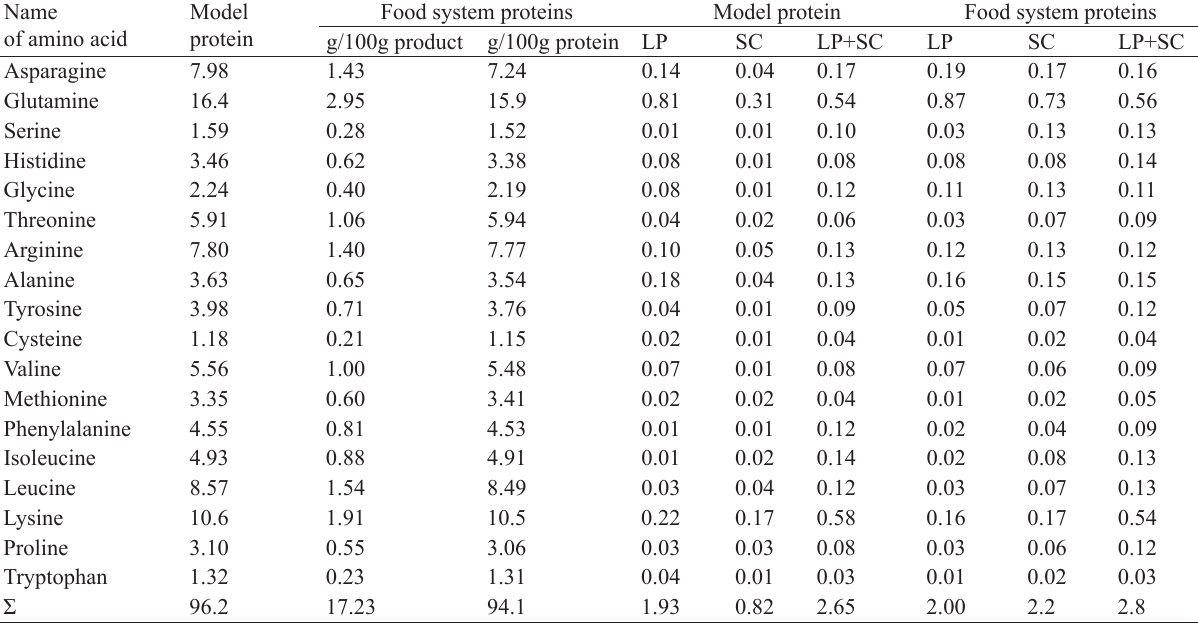
Table 1 Amino acid composition of model and food system proteins and the content of free amino acids after treatment with Lactobacillus plantarum and Staphylococcus carnosus Name of amino acid